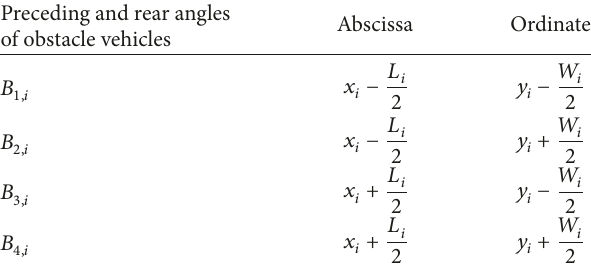
Table 1: Preceding and rear point coordinates of obstacle